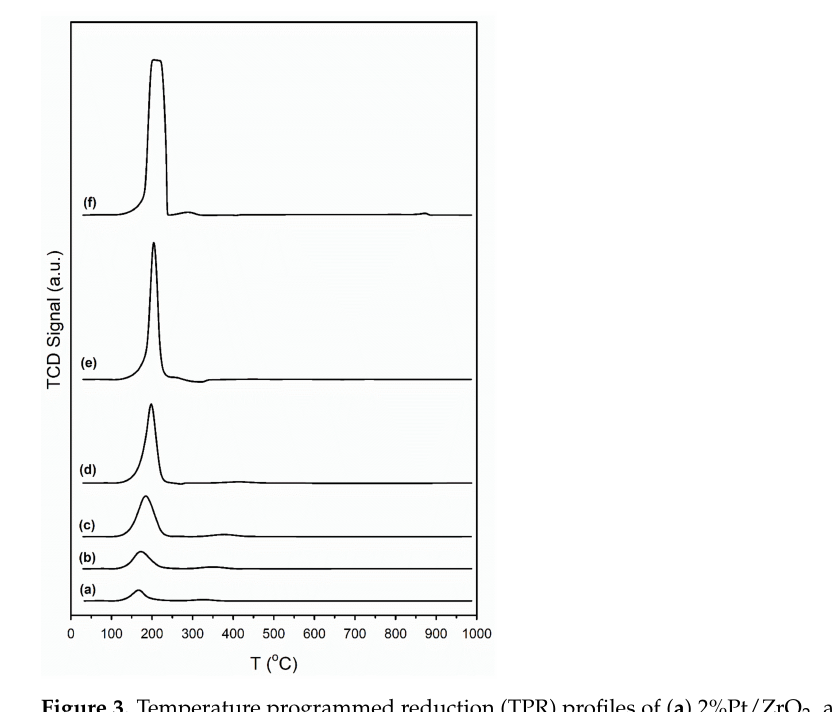
Figure 3. Temperature programmed reduction (TPR) profiles of ( a ) 2%Pt/ZrO 2 , and the same doped with ( b ) 0.55%Rb, ( c ) 1.86%Rb, ( d ) 2.79%Rb, ( e ) 4.65%Rb, and ( f )